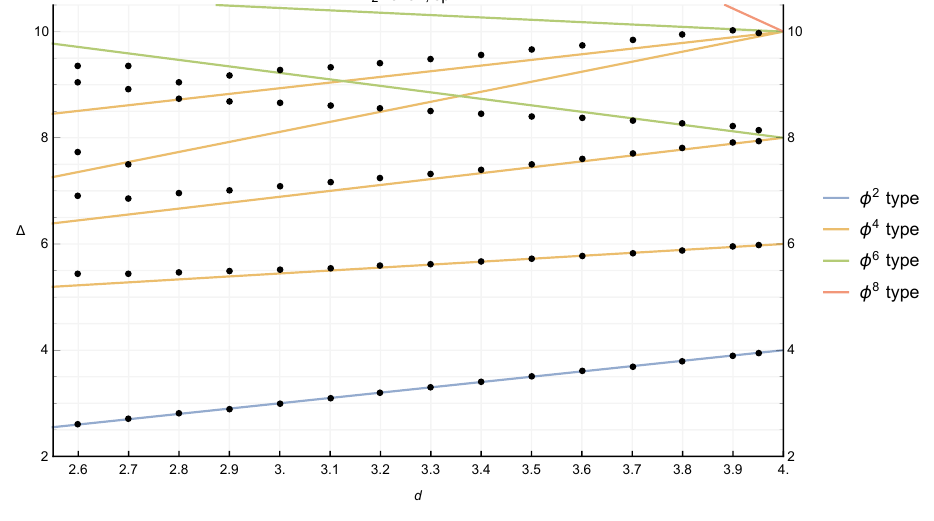
Figure 5 . Z 2 -even operators of spin 2.